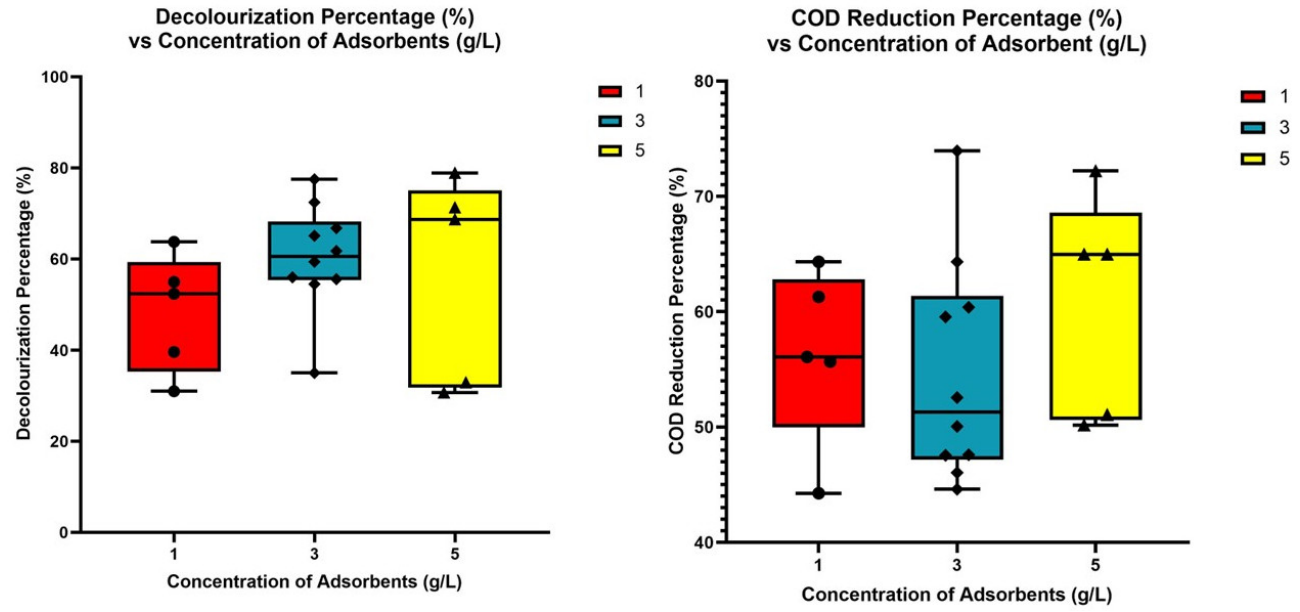
Figure 11. The decolourisation percentages ( left ) and COD reduction percentages ( right ) of STDW based on the concentration of adsorbents. based on the concentration of adsorbents.